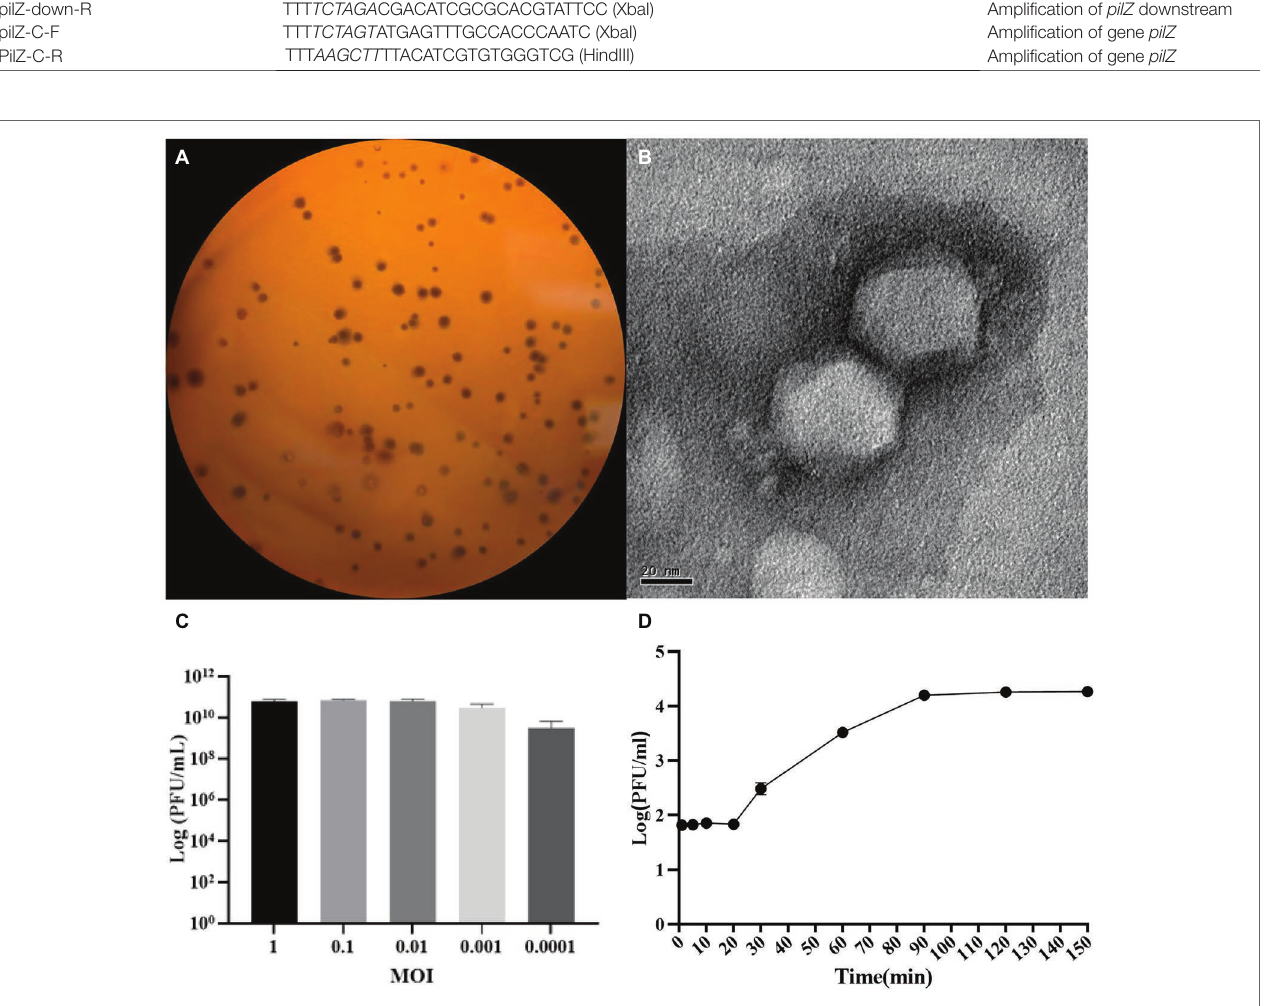
FIGURE 1 | The morphological characteristics of Pseudomonas aeruginosa phage L5. (A) Plaque morphology of L5 on P. aeruginosa strain PAO1r; (B) Transmission electron micrograph image of L5. The scale bar represents 20 nm; (C) The multiplicity of infection (MOI) of L5; (D) The one-step growth curve of L5 on P. aeruginosa strain PAO1r. Error bars indicate standard deviation.